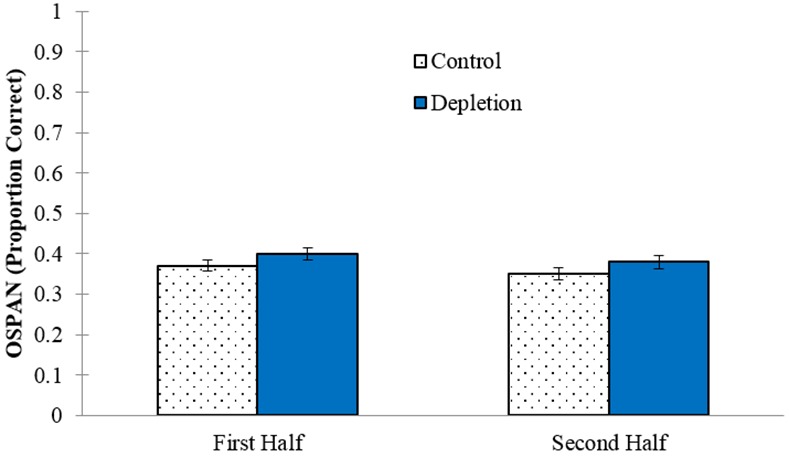
Condition differences on OSPAN performance between the first and second half of the task.Error bars represent SEM.